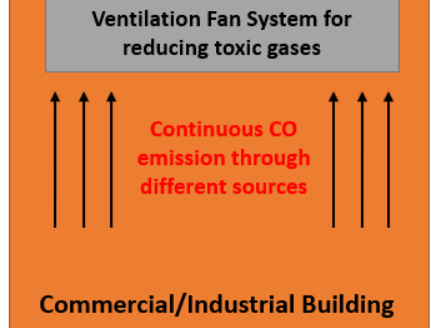
Figure 4. Commercial building ventilation system.